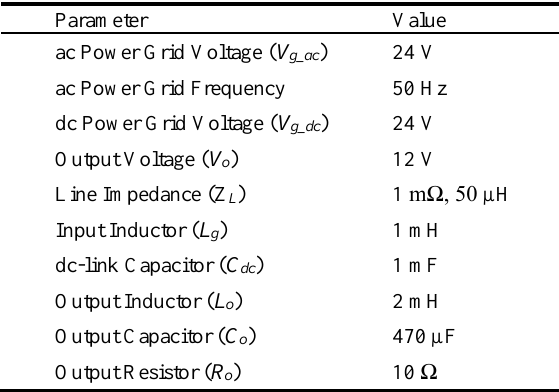
Table 1. Simulation model